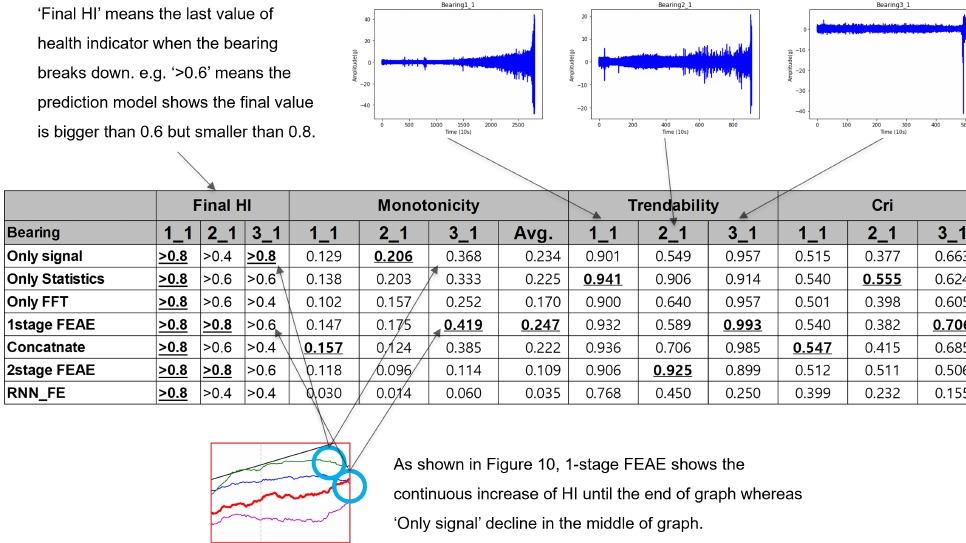
Figure 17. Performance comparison of the proposed method and previous